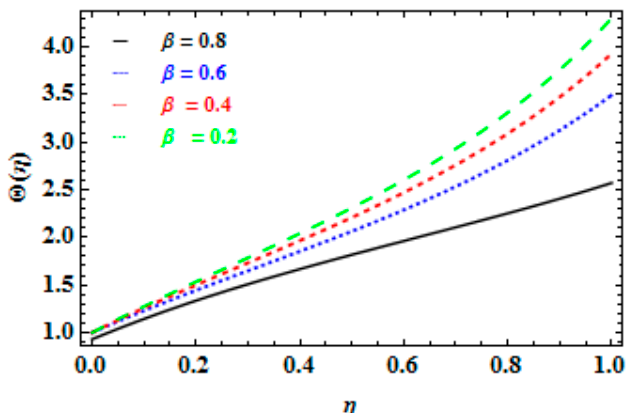
β β on Θ ( 𝜂 ) . on Θ ( 𝜂 ) .